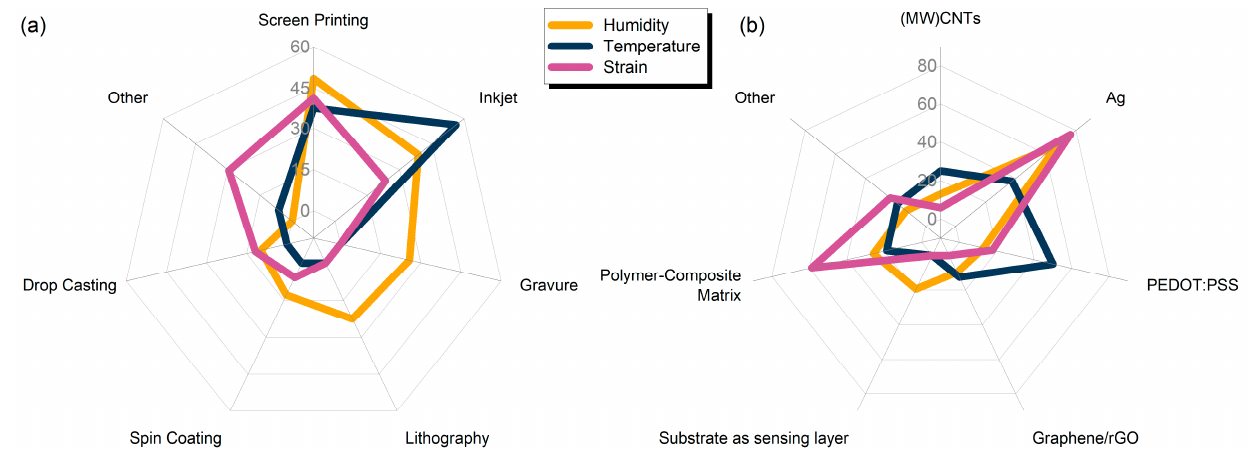
Figure 4. ( a ) Radar plot with utilization percentage values for different fabrication techniques for all the sensor categories; ( b) material selection for electrodes and sensing